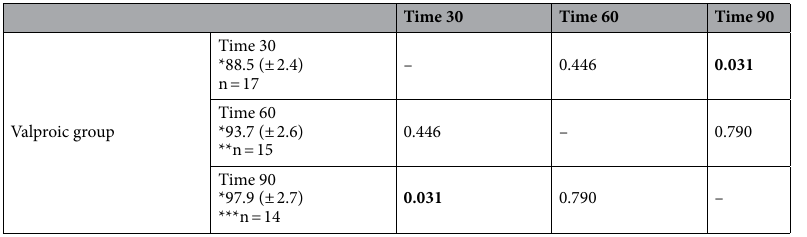
Valproic acid group N